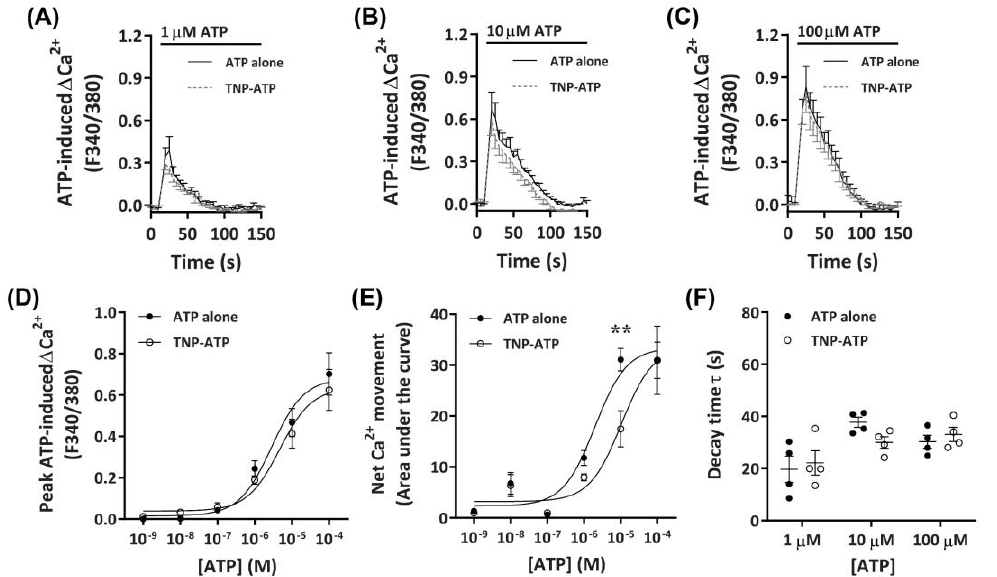
Figure 3. ATP-induced Ca 2 + responses in DH82 cells in the absence or presence of 2 (cid:48) ,3 (cid:48) - O -(2,4,6- trinitrophenyl)-ATP (TNP-ATP). ( A–F ) DH82 cells in ECS were loaded with Fura-2 and